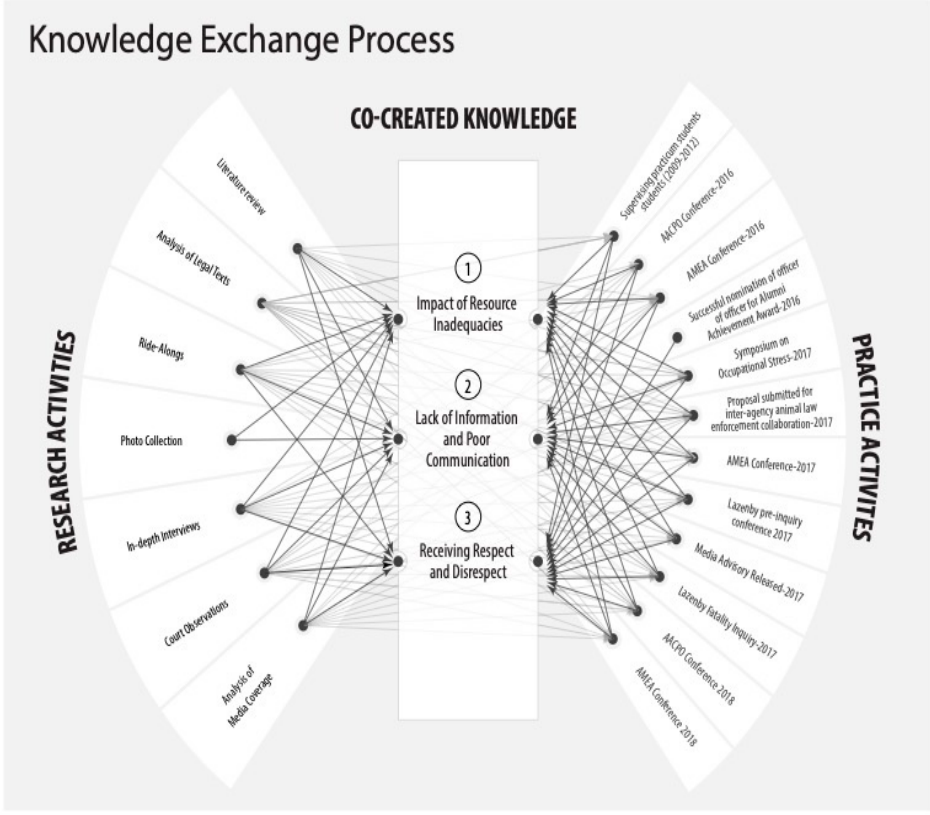
Figure 2. Knowledge generation and exchange. Adapted with permission from [27], 2019, Rault.